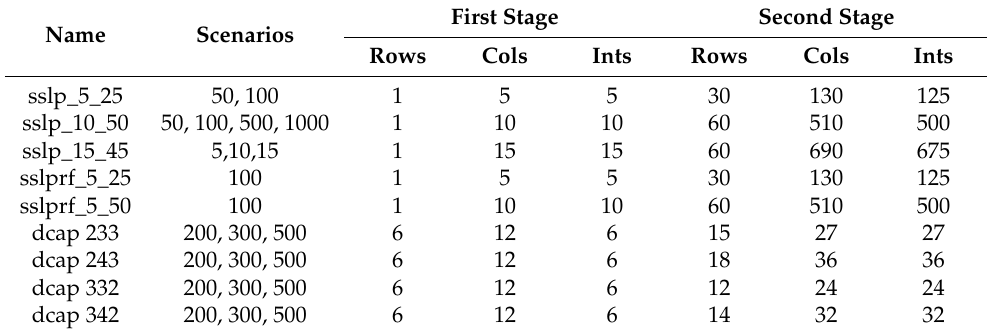
Table 1. The sizes of the problems